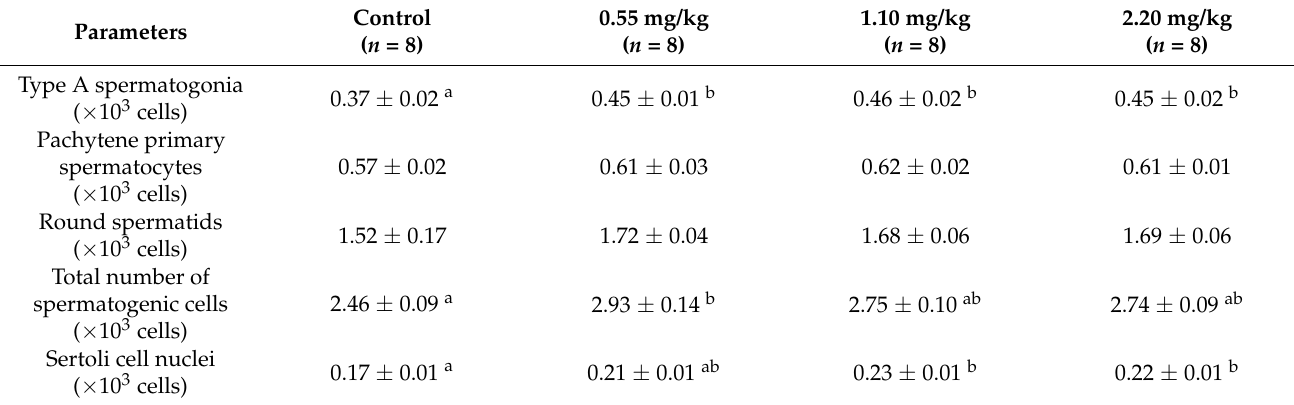
Table 7. Numbers of spermatogenic and Sertoli cell nuclei in cross-section of seminiferous tubule at stage VII-VIII of the male rats treated with M. oleifera leaf tea in the different dose for 30 days, compared with control.